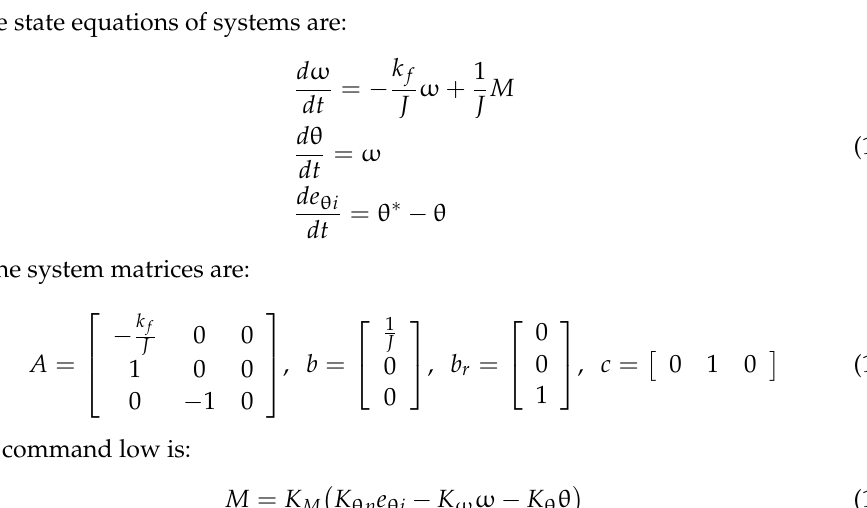
Figure 5. Block diagram of state feedback control system.